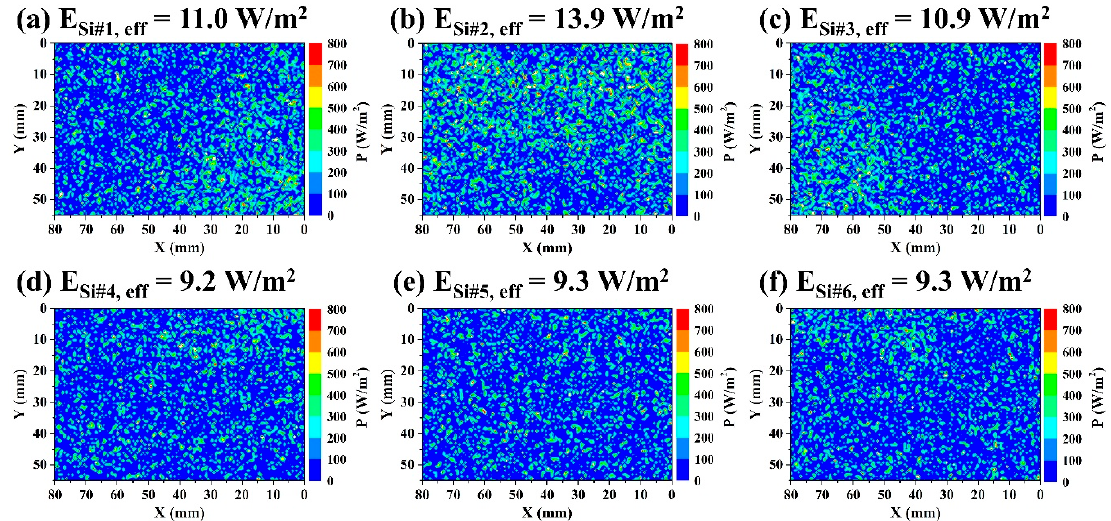
Figure 4. Irradiance distributions of the six silicon solar cells for a pyramidal SOE with θ = 30° and h = 15 mm: ( a ) Si #1, ( b ) Si #2, ( c ) Si #3, ( d ) Si #4, ( e ) Si #5, and ( f ) Si #6. The size of each cell was 80 × 55 mm 2 .